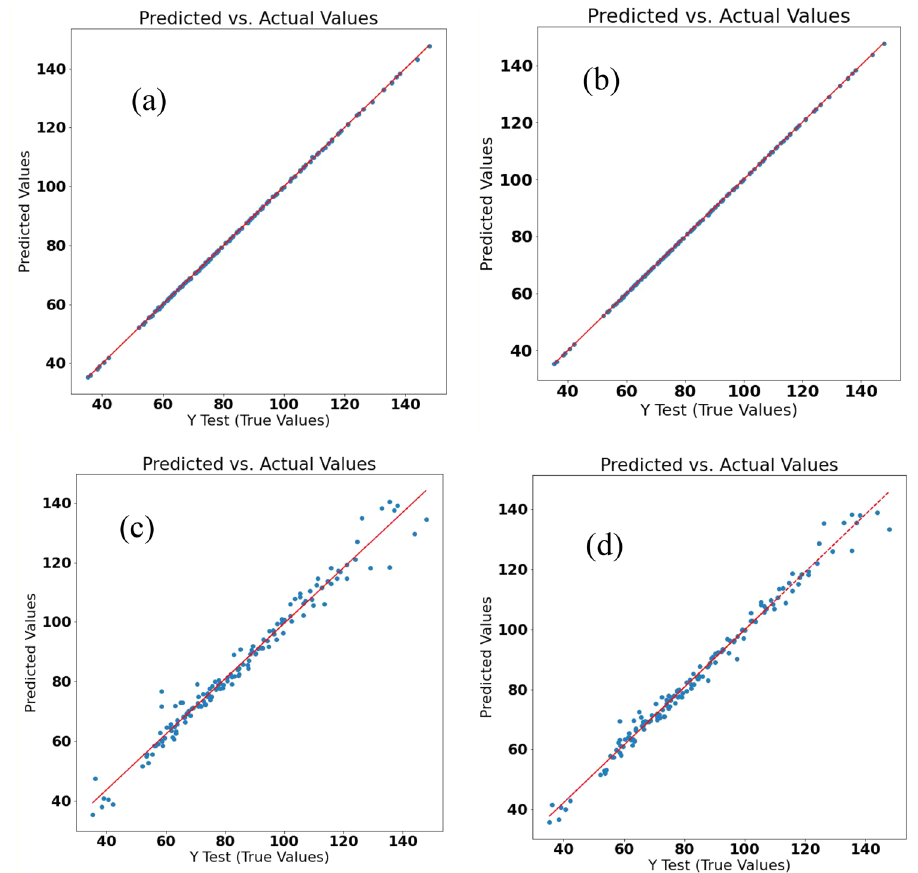
Figure 1. ( a ) Linear ( b ) Support vector, ( c ) Random forest, and ( d ) gradient boosting regressions of the grain yield per unit area of the Lallemantia iberica ecotypes based on machine learning